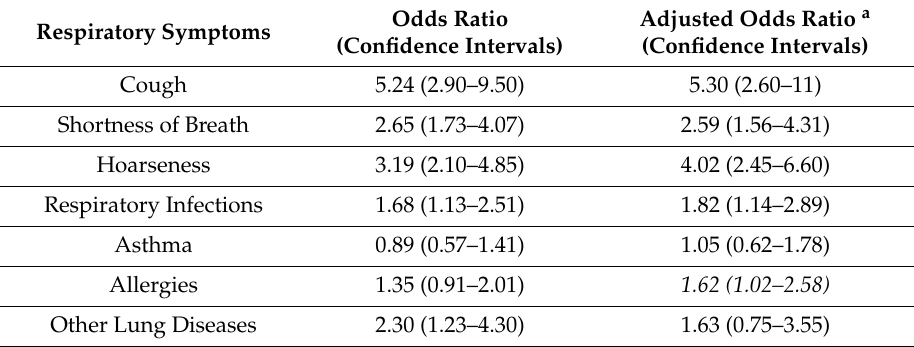
Table 3. Logistic regression results for respiratory symptoms and health outcomes.